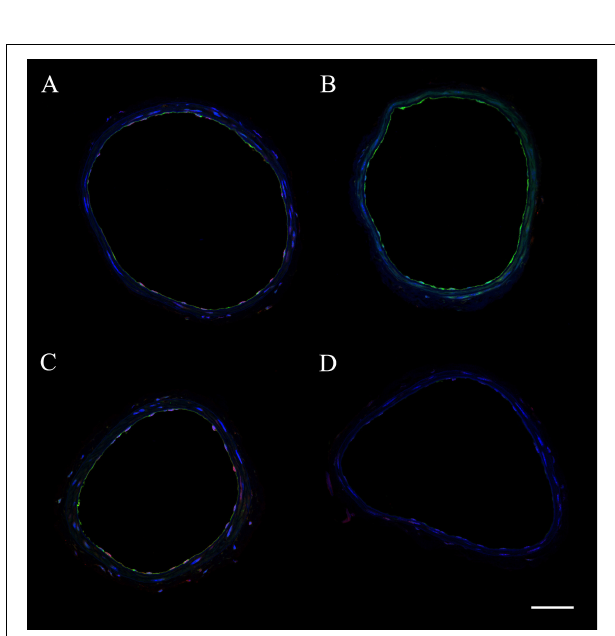
FIGURE 7 | Representative images of internal carotid artery cross sections from C57BL/6 wild-type (WT) virgin (A) , WT 4 weeks PP (B) , CD4 T cell deficient (CD4KO) virgin (C) , and CD4KO 4 weeks PP (D) mice. eNOS is shown in green and iNOS – in red. Endothelial and smooth muscle cell nuclei are stained in blue (DAPI). The scale bar is 50 µ